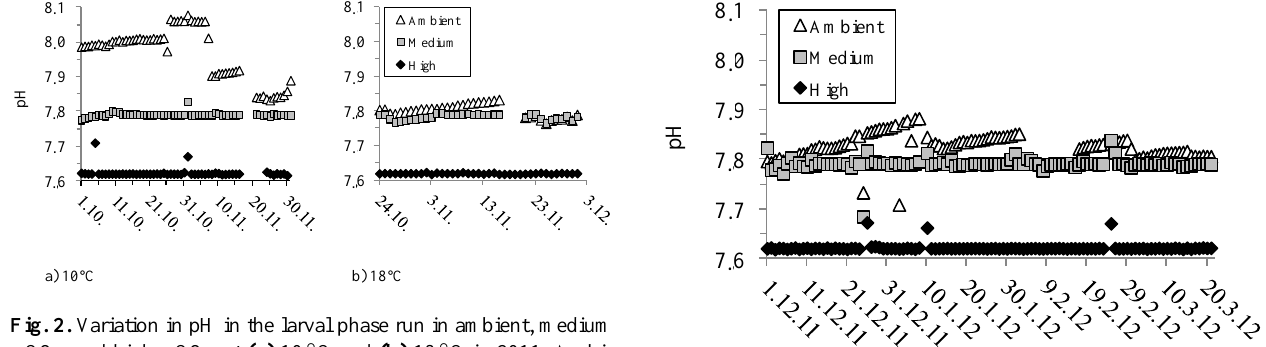
Fig. 3. Variation in pH in the juvenile phase in ambient, medium p CO 2 and high p CO 2 until 22 march 2012 in the experiments run at 18 ◦ C. Ambient is raw water from 90m depth. Note that only juveniles in 18 ◦ C were monitored, as non larvae reached a viable stage 4 in 10 ◦